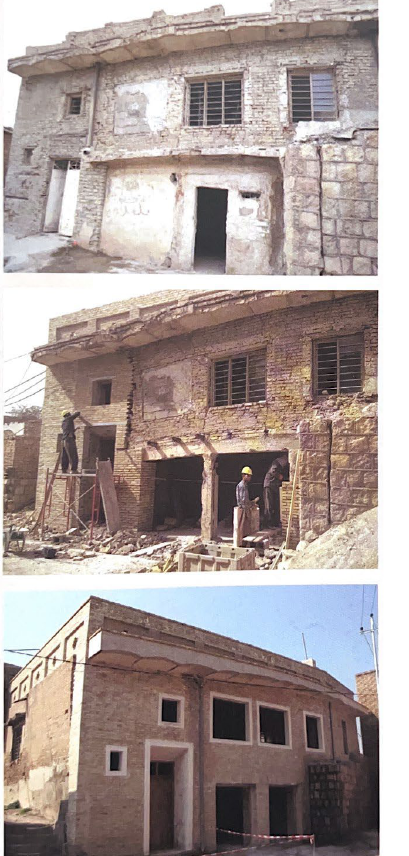
Figure 14 . Diagnosis of the defaults and cracks in the ceilings and envelop after the refurbishment process by author.